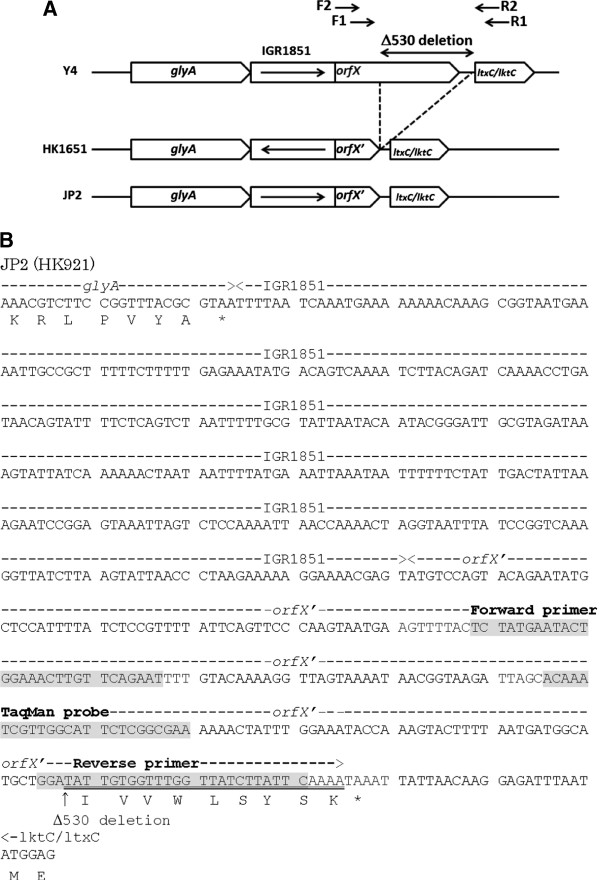
Comparison of (A) the genetic organization of JP2 clones and non-JP2 strains and (B) the nucleotide sequences of the glyA gene and orfX (orfX')-lktC locus of the JP2 strain. (A) The ∆530-bp deletion of the JP2 strain was identified. F1 and R1, Aa orfX3'F1 and Aa lktC5'R1; F2 and R2, Aa orfX3'F2 and Aa lktC5'R2. (B) The nucleotide sequence of the JP2-specific primer–probe set. The arrow indicates the ∆530-bp deletion. The double underlined amino acid sequence (IVVWLSYSK) overlaps the 3' locus of orfX